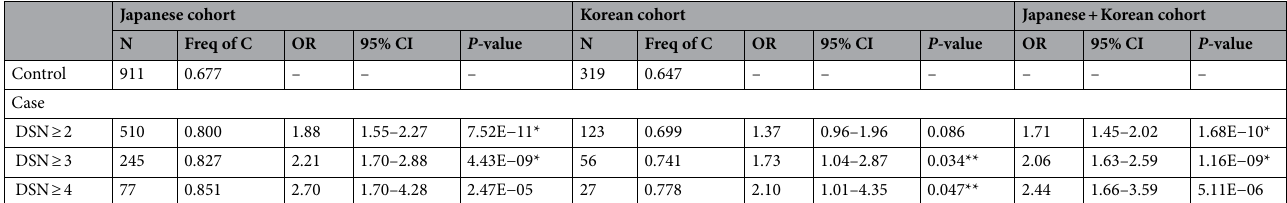
Table 3. Impact of rs2054564 on the development of severe lumbar spondylosis in Japanese and Korean cohorts. Adjusted for age, sex, and BMI by logistic regression model. N number, DSN disc space narrowing, Freq frequency, OR odds ratio, CI confidence interval. *Statistically significant with P -value < 5.0 × 10 –8 , a genome-wide significance threshold. **Statistically significant with P -value < 0.05.